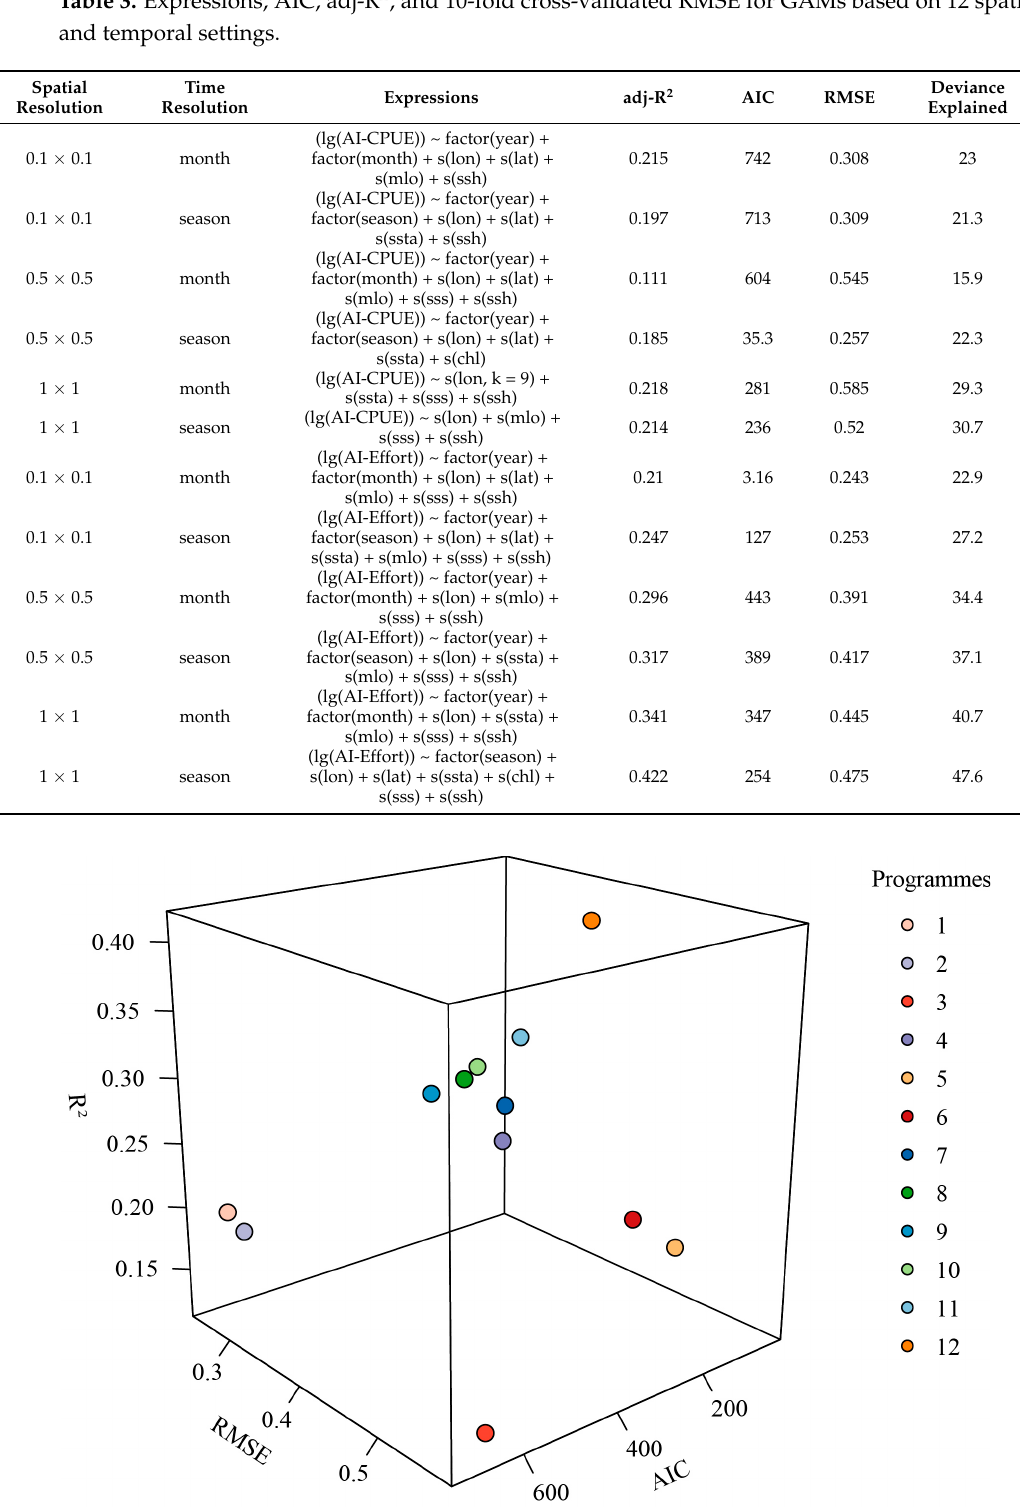
Figure 3. Distribution of adj-R 2 , AIC, and ten-fold cross-validated RMSE on 3D scatterplots based on GAMs for 12 spatial and temporal settings.